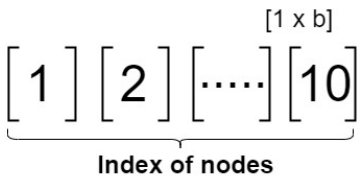
Figure 2. Solution